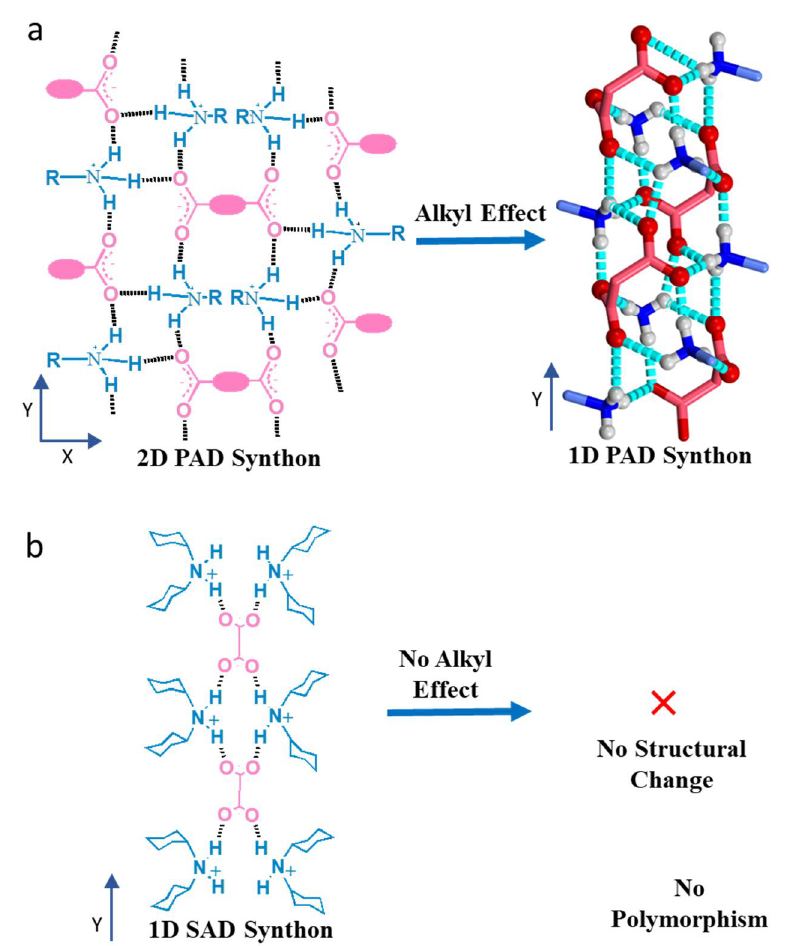
Figure 1. Alkyl effects on dicarboxylate salts. ( a ) Van der Walls’s interaction at an increased alkyl chain in the amine part transforms the 2D Primary Ammonium Dicarboxylate (PAD) synthon to 1D synthon. The backbone of a dicarboxylic acid, marked by pink ovals, acts as a linker between the two parallel 1D hydrogen-bonded network (Y axis) to propagate an orthogonal growth towards the X-axis in building an overall 2D synthon. After increasing the carbon chain length at the primary amine part, the alkyl group (light blue) shows the lamellar effect with 360° orientation around the 1D synthon and bends the carboxylic acid backbone to generate the tubular structure. ( b ) No alkyl effect was found on the robust 1D Secondary Ammonium Dicarboxylate (SAD) synthon.